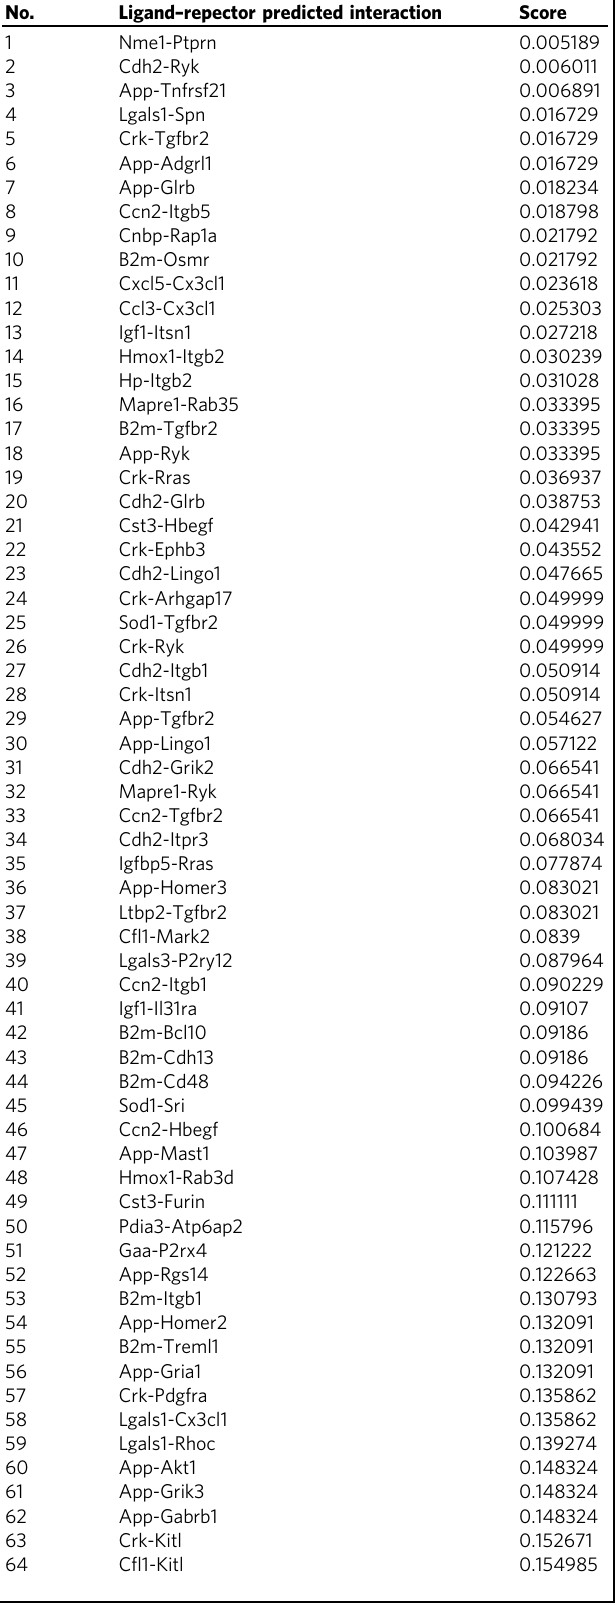
Table 1 SEARCHIN-based prioritization of candidate ligand – receptor